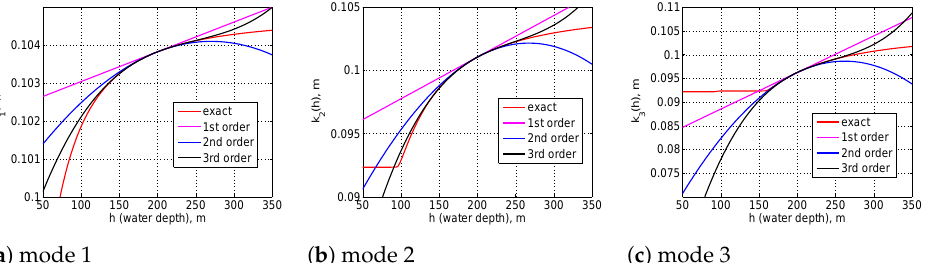
Figure 3. Dependence of k j ( h ) in the coastal wedge and its approximations by perturbative